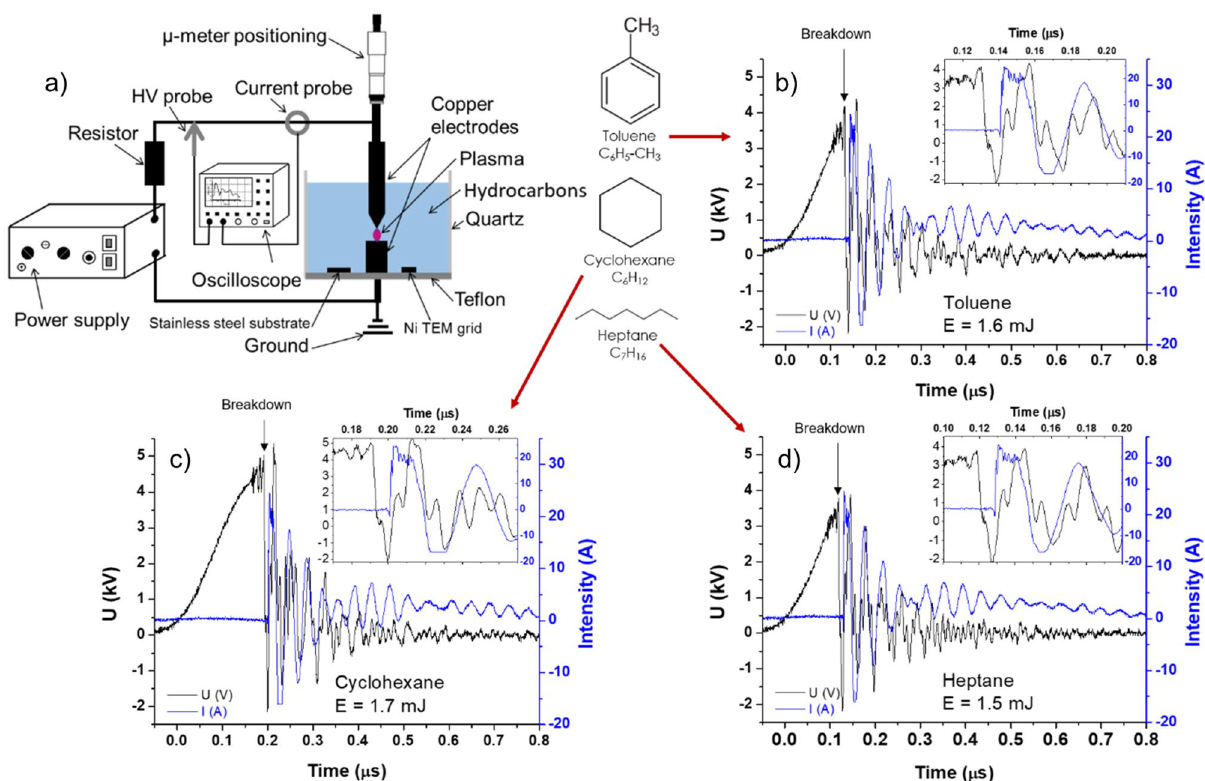
Figure 8. ( a ) Schematic of the experimental setup used to produce spark discharges between two copper electrodes immersed in various liquid HCs: toluene, cyclohexane, and heptane. ( b – d ) The I–V characteristics of a typical discharge in each condition are also displayed. The insets highlight the evolutions of the I–V curves after the